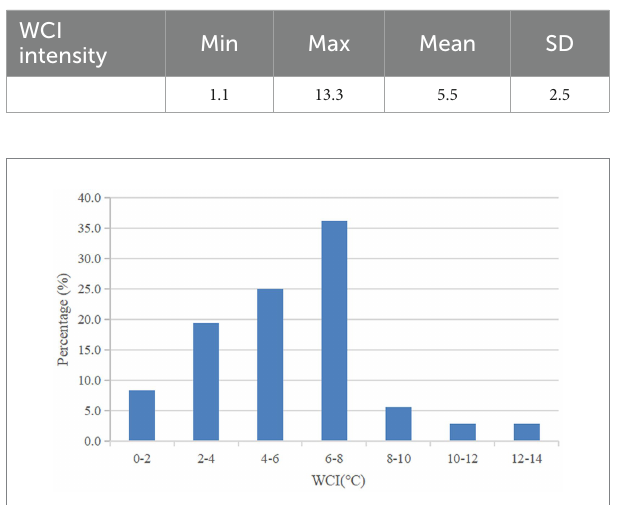
TABLE 3 WCI intensity of water bodies ( ° C).